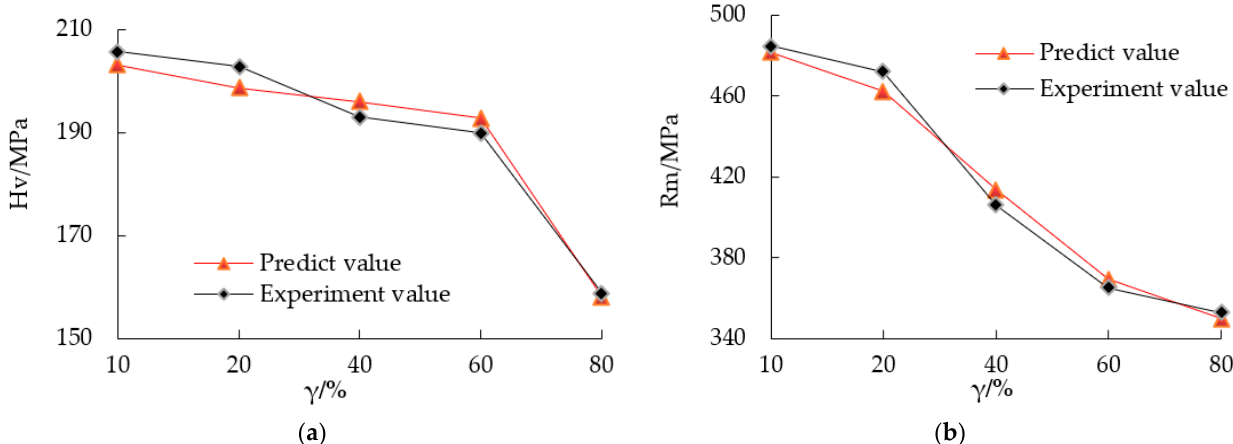
Figure 6. Comparison between the experimental and predicted values with different duty cycles. ( a ) Microhardness and ( b ) tensile strength.